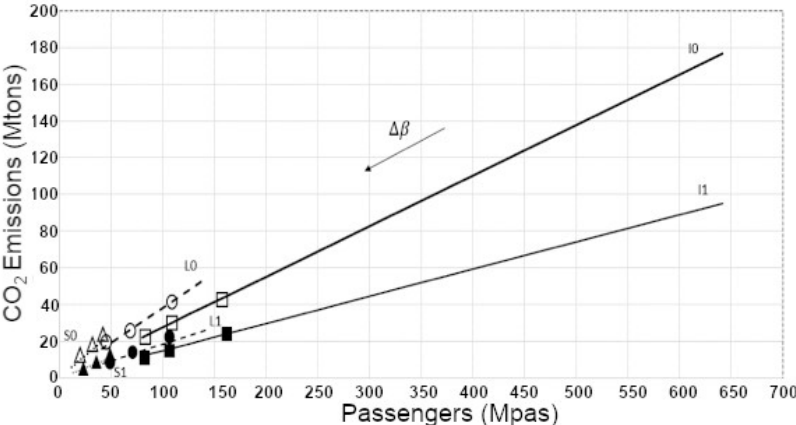
Figure 2. Dependence of the location of the model equilibrium points in the phase diagram, on the β values. The direction of increase of the β parameter values is indicated with an arrow. The points labelled with symbols correspond to the three cases where equilibrium points for three given β values (1, 1.5, and 2), which could be found for the three types of flights. Triangles indicate the National flights type (S), the circles depict the Intra-European flights (L), and squares correspond to Extra-European ones (I). The symbols are white when the parameter values corresponded to the case (0), while they are black in the case (1). The lines mark the position of all the other equilibrium points in the cases S (dash lines), L (dashed lines), and I (solid line). The upper lines correspond to the subcases 0 and the lower ones to the subcases 1 of each type of